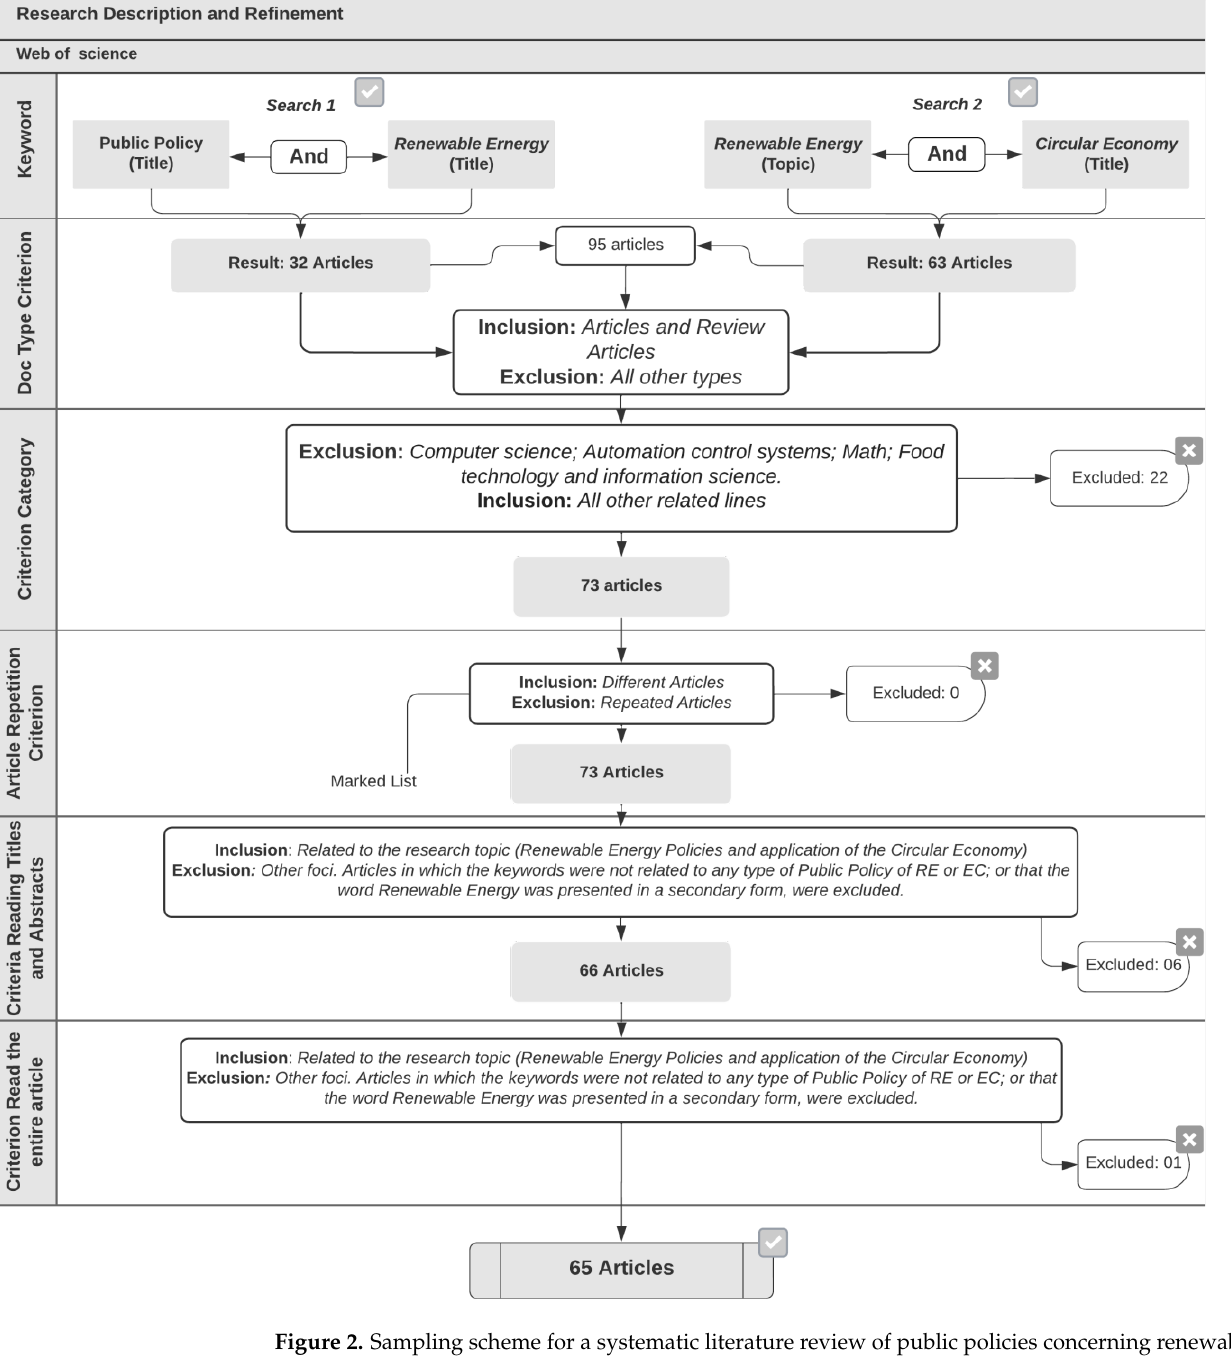
Figure 2. Sampling scheme for a systematic literature review of public policies concerning renewable energies from a CE perspective.